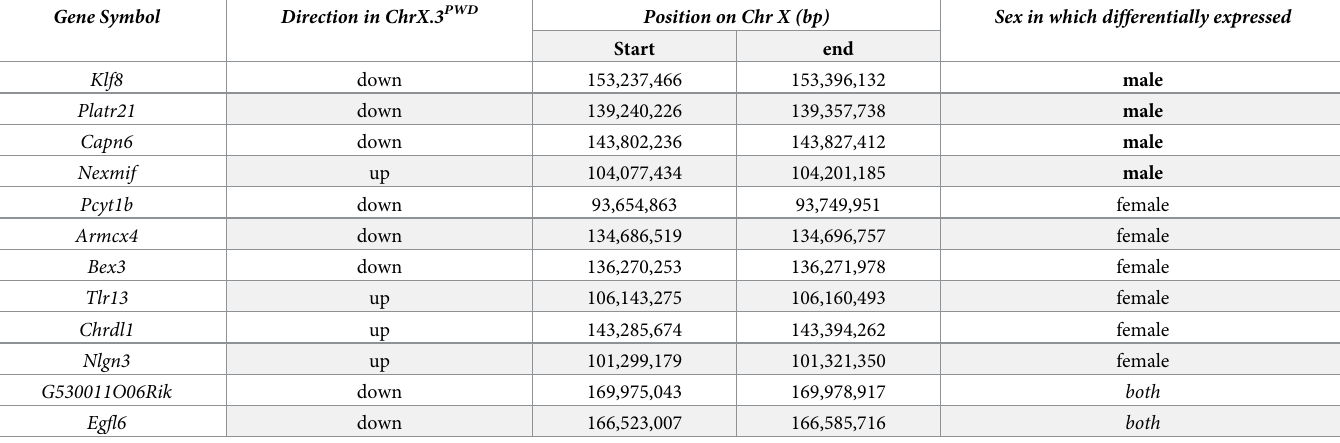
Table 3. Positional candidate genotype-dependent DEGs that mapped to ChrX.3 interval. Genes differentially expressed between ChrX.3 males and B6 males (male), ChrX.3 females and B6 females (female), or in both sexes (both), which mapped to Chr X.3 interval (Chr = X; position = 88,400,000 bp or greater) from the RNAseq data described in Fig 6 . Direction of change, up indicates increased expression in ChrX.3 relative to B6, down indicates decreased expression. A cutoff filter of |log2(Fold- Change)| = 0.6, Padj = < 0.05 was used to identify DEGs. Gene